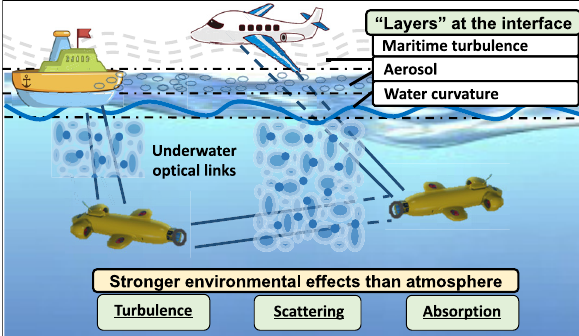
Figure 6: Challenges of different scenarios in underwater free- space optical